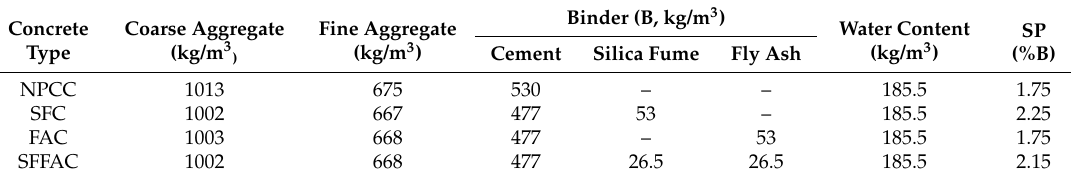
Table 1. Details of concrete mix